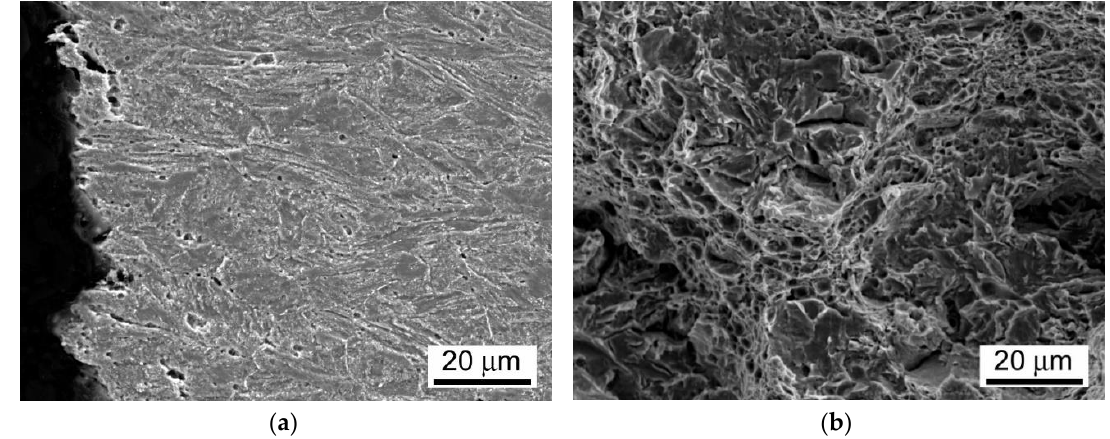
Figure 16. Fracture analysis of hydrogen-charged T92/T92 weldment initially processed by the PWHT-2 and subsequently ruptured in WM after the room-temperature tensile test: ( a ) fracture path and microstructure beneath the fracture; ( b ) fracture surface showing mixed fracture consisting of transgranular quasi-cleavage with a “fish-eye” morphology besides ductile dimple ridges and some inter-lath decohesion areas.